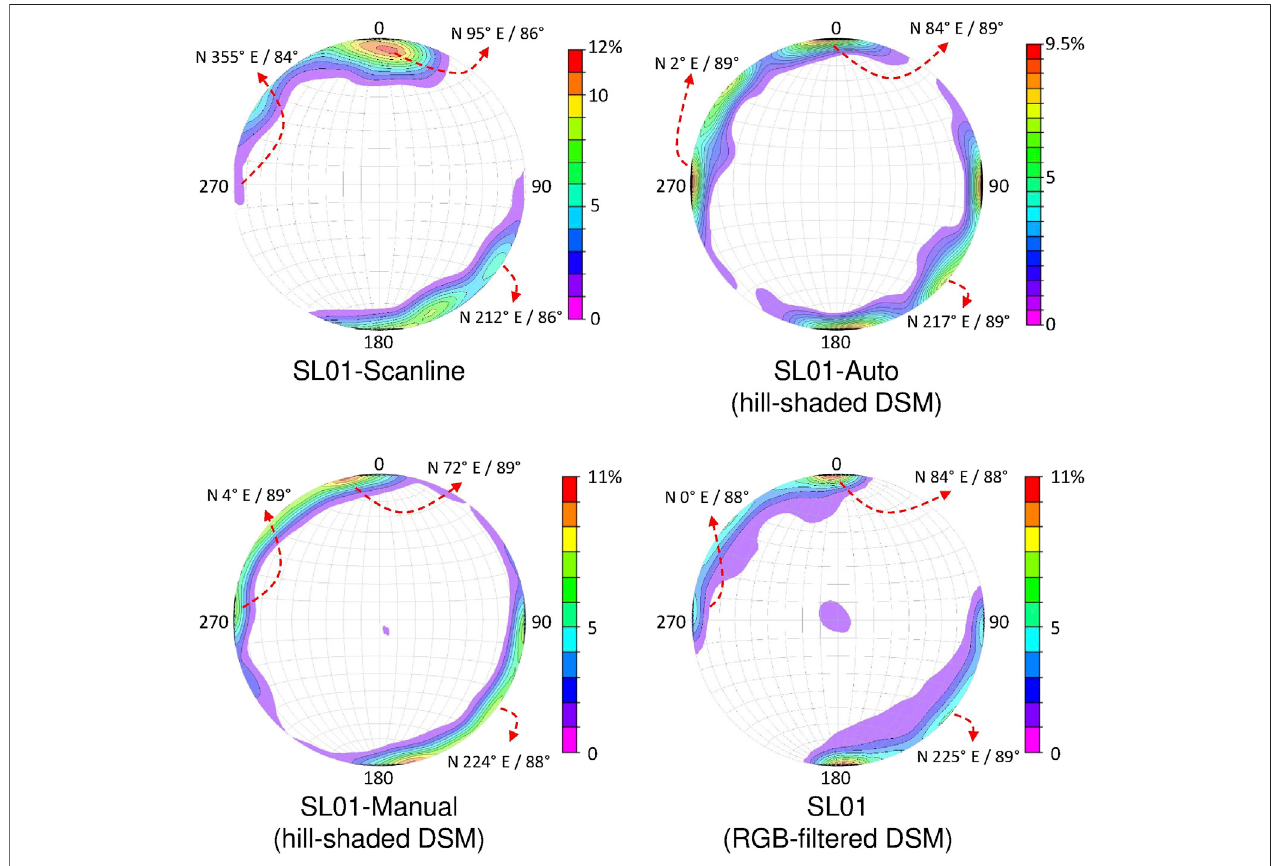
FIGURE 8 | Lower-hemisphere stereographic projections of fracture planes generated from the simple triangulation method for SL01 outcrop. All DSM methods show nearly identical outcomes compared to the result from the scanline regarding true strike direction and dip angle.